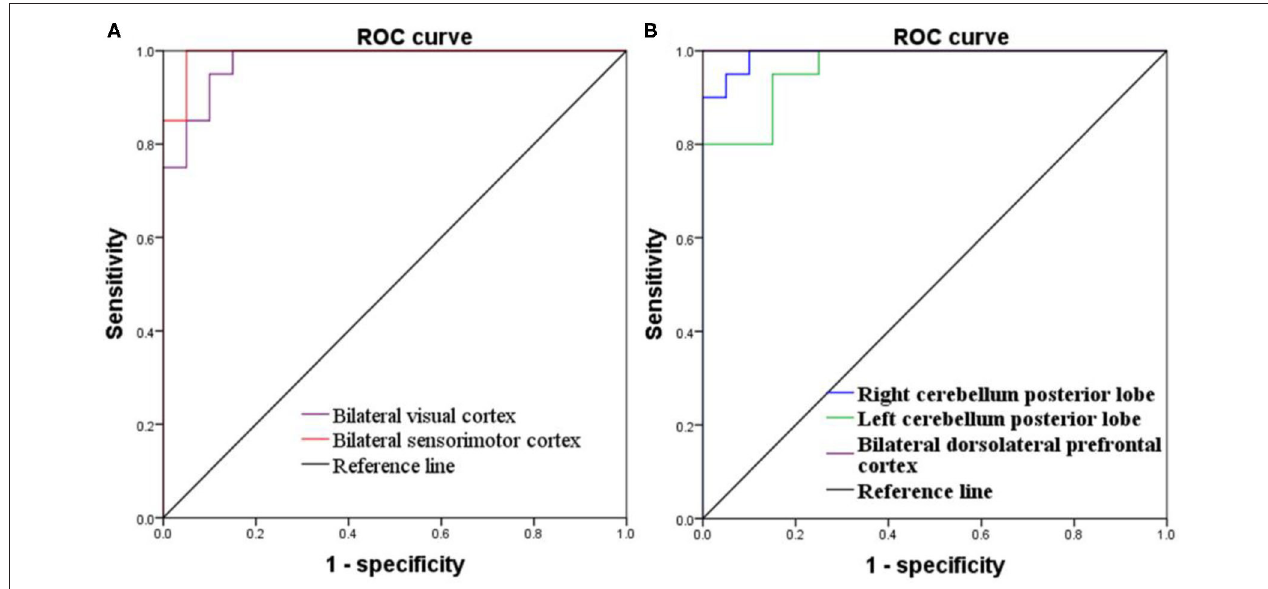
FIGURE 4 | ROC curve of PerAF differences in brain areas. (A) Increased PerAF areas; (B) Decreased PerAF areas. ROC, receiver operating characteristic; PerAF, percent amplitude of fluctuation.